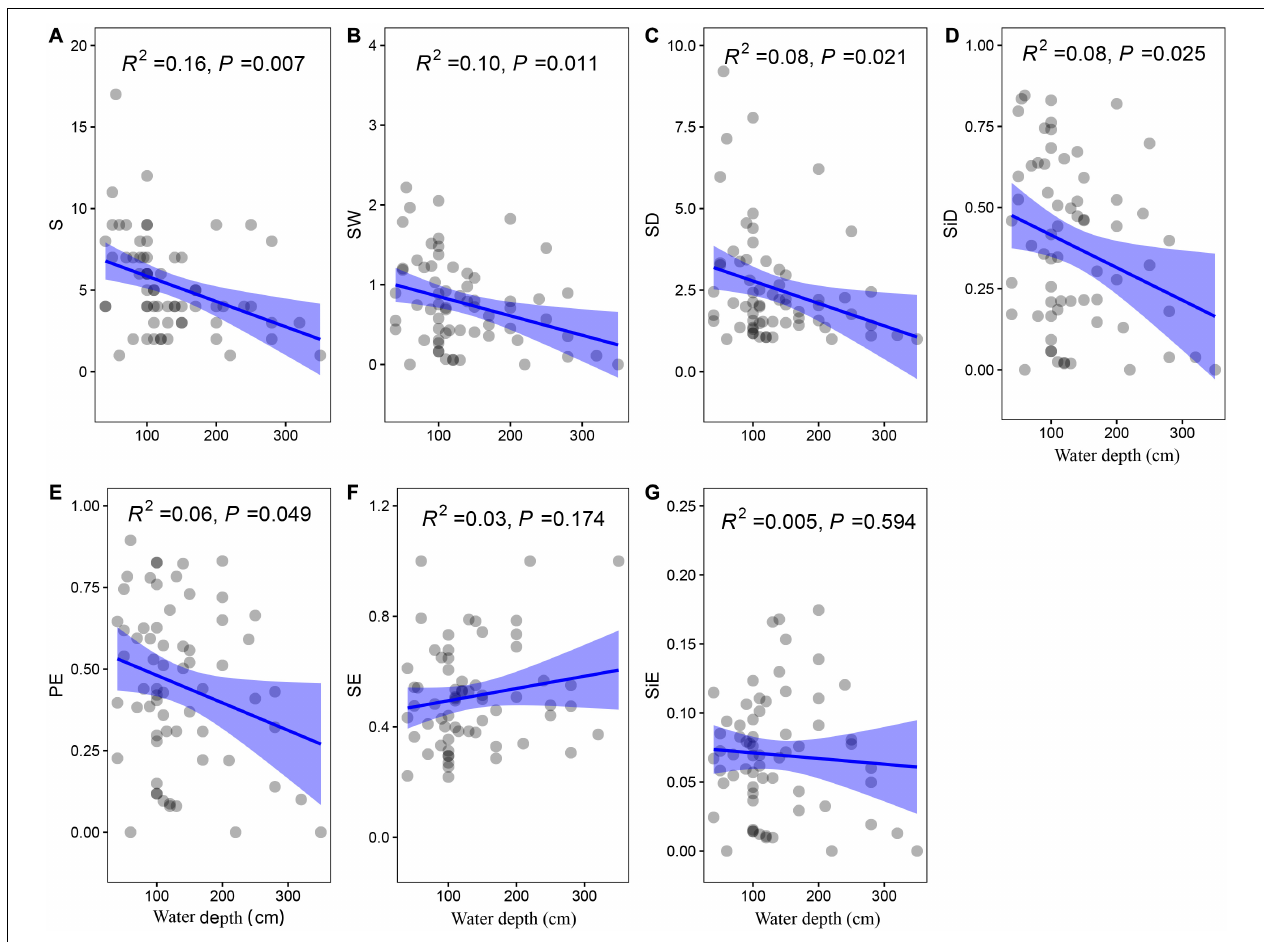
FIGURE 6 | The least-squares linear regressions between water depth and (A) richness, (B) Shannon–Wiener index, (C) Shannon diversity, (D) Simpson diversity, (E) Pielou evenness, (F) Shannon evenness, and (G) Simpson evenness. The regression coefficients squared and P -values are given for the regression. The blue area shows the approximate 95% confidence intervals on the fitted function ( n =